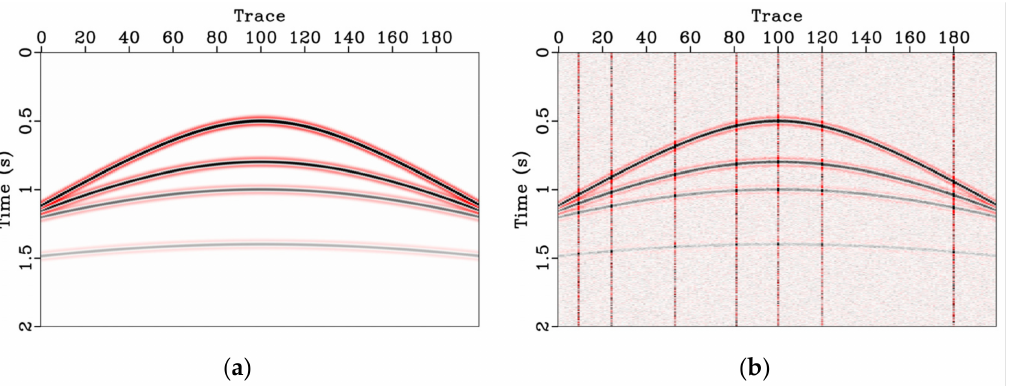
Figure 3. Synthetic data. ( a ) A noise-free common-shot gather. ( b ) Noisy gather with random and outlier noise (SNR = − 5.25 dB, PSNR = 12.47 dB).